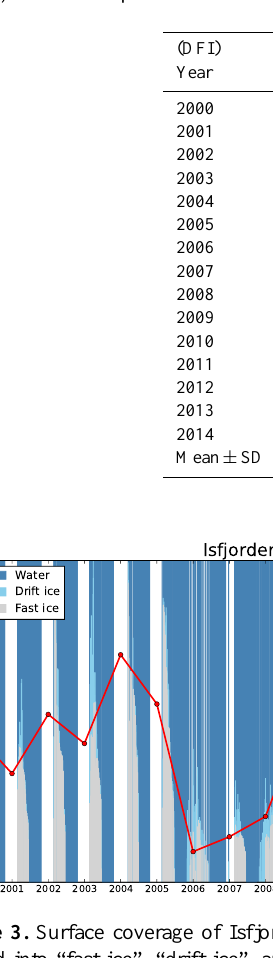
Table 2. Calculated “days of fast ice” (DFI) for Isfjorden and Hornsund between 2000 and 2014 for two different time periods. “Total season” refers to the entire sea ice season starting during autumn of the previous year and “short season” refers to 1 March until the end of the ice season, i.e. the time period when VIS/NIR images are available. (cid:49) describes the difference between the entire and short season.